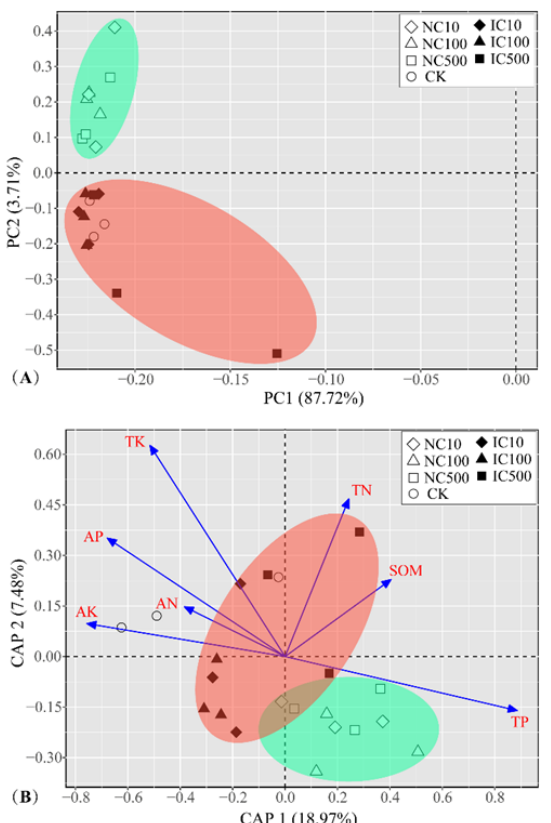
Figure 3. Coordinate biplot of PCA ( A ) and CAP ( B ) for soil bacterial community composition at genus level. PCA, principal component analysis; CAP, constrained analysis of principal coordinates.